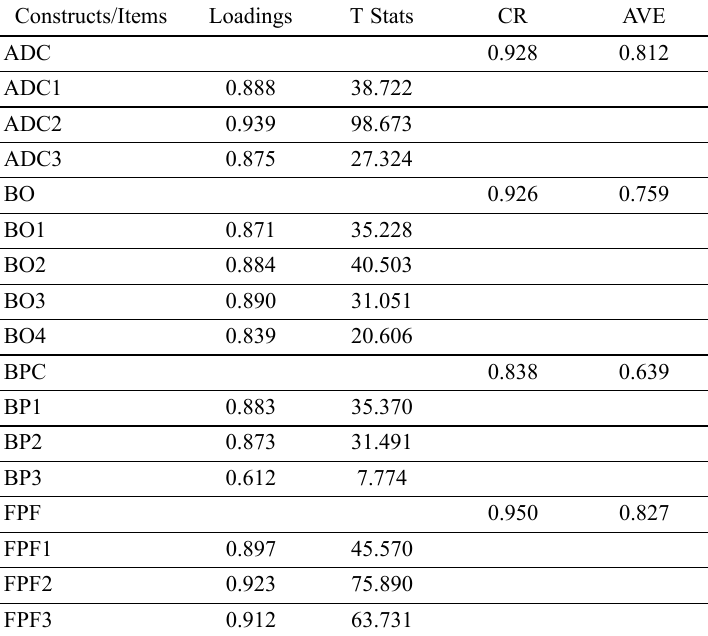
Table 2. Indicator loadings, construct reliability with convergent